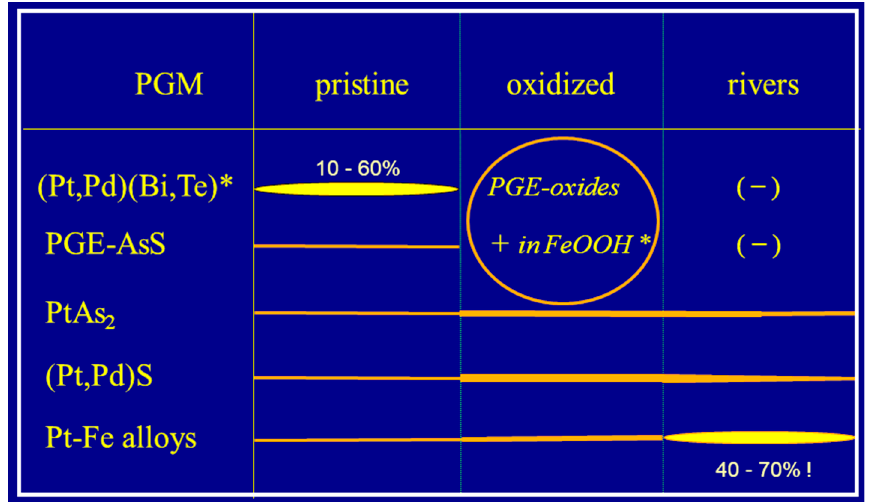
Figure 7. Schematic graph showing the principal changes of the PGM assemblages from pristine, sulfide ores via oxidized ores into placer accumulations. Abbreviations: (Pt,Pd)(Bi,Te)* = (Pt,Pd)-bismuthotellurides; FeOOH* stands for Fe,Mn,Co-oxides/hydroxides. Note that Pt–Fe alloys include native Pt.